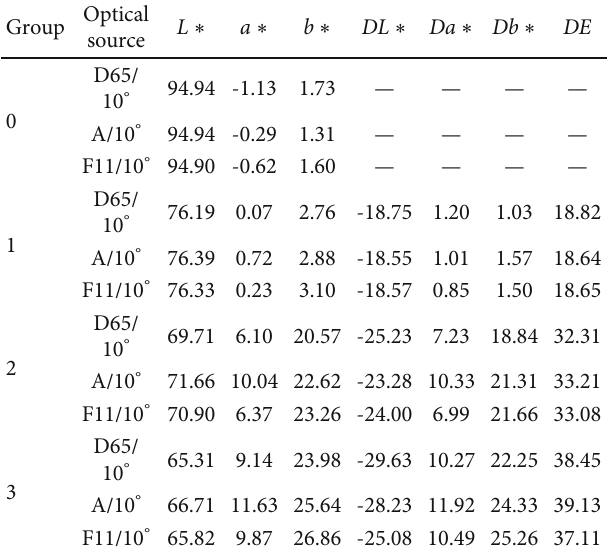
Figure 5: Digital photos of PVDF-coated fabrics before and after degradation: (a) unaged fabrics of group 0, (b) aged fabrics of group 1, (c) aged fabrics of group 2, and (d) aged fabrics of group 3. Table 3: Chromaticity data evolution of experimental PVDF- coated